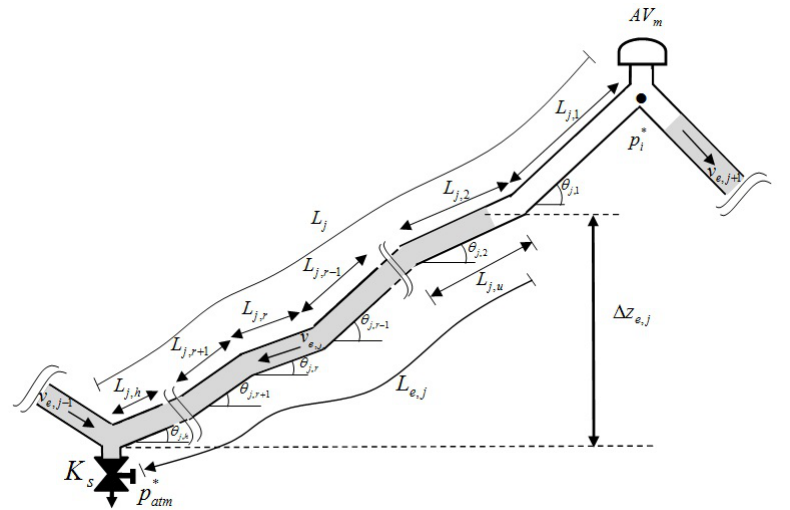
Figure 2. Evolution of the gravity term of the emptying column j .